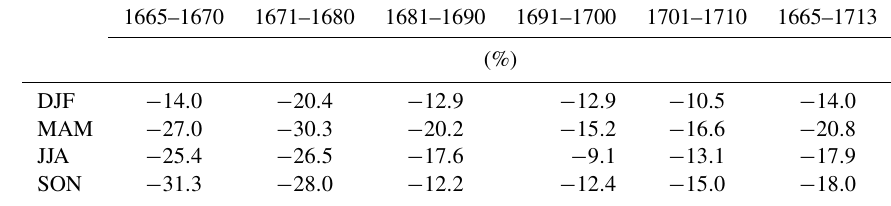
Table 4. Anomalies in Morin’s TCC notes with respect to the mean of present time series TCC (ERA5 Dataset; 1981–2010).